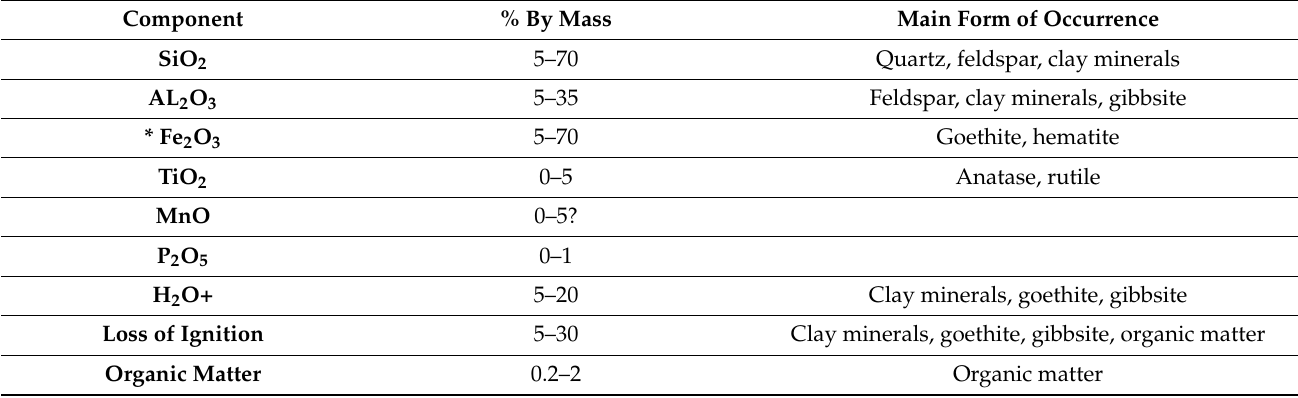
Figure 10. Refs. [36,37]: Distribution of the main soil types commonly referred to as “Laterites”—these softs extend beyond the tropics in favourable circumstances, including high-rainfall, sub-tropical, continental East coasts (Ferrallitic soits) and the West coast/Mediterranean and continental interiors in mid latitudes (Fersiallitic soits). Table 4. Typical variation in mineralogy of Lateritic material